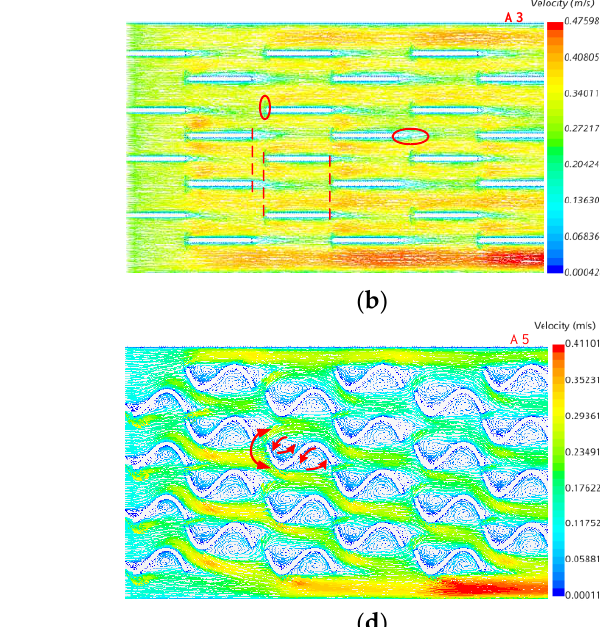
Figure 8. Velocity distribution of A2~A5. ( a ) A2 (h = 2.5 mm); ( b ) A3 (h = 1.2 mm); ( c ) A4 (h = 1.2 mm); ( d ) A5 (h = 2.5 mm).